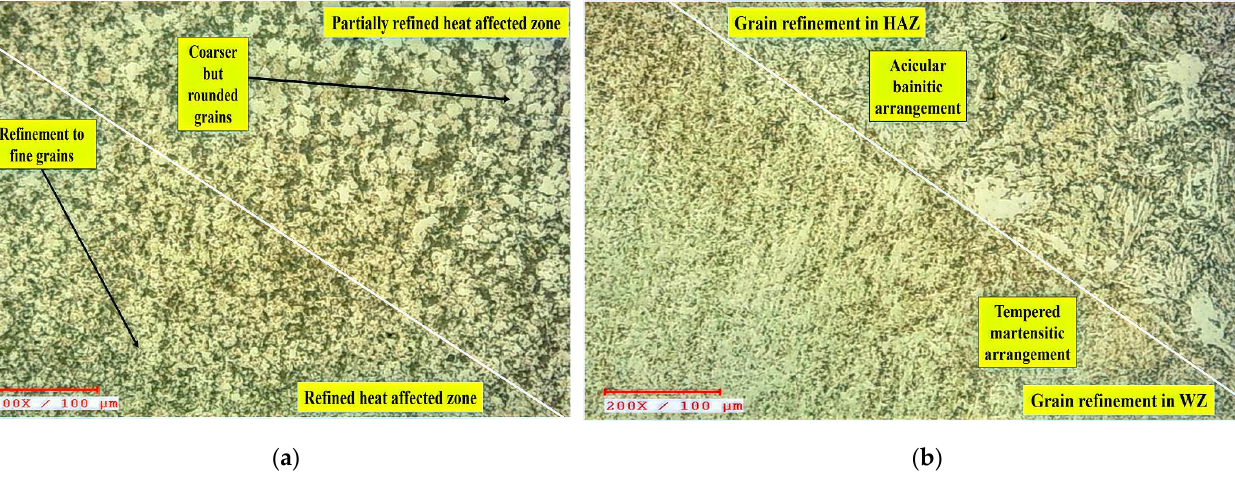
Figure 9. Surface morphological changes post-heat treatment in ( a ) HAZ and ( b ) HAZ-WZ interface.